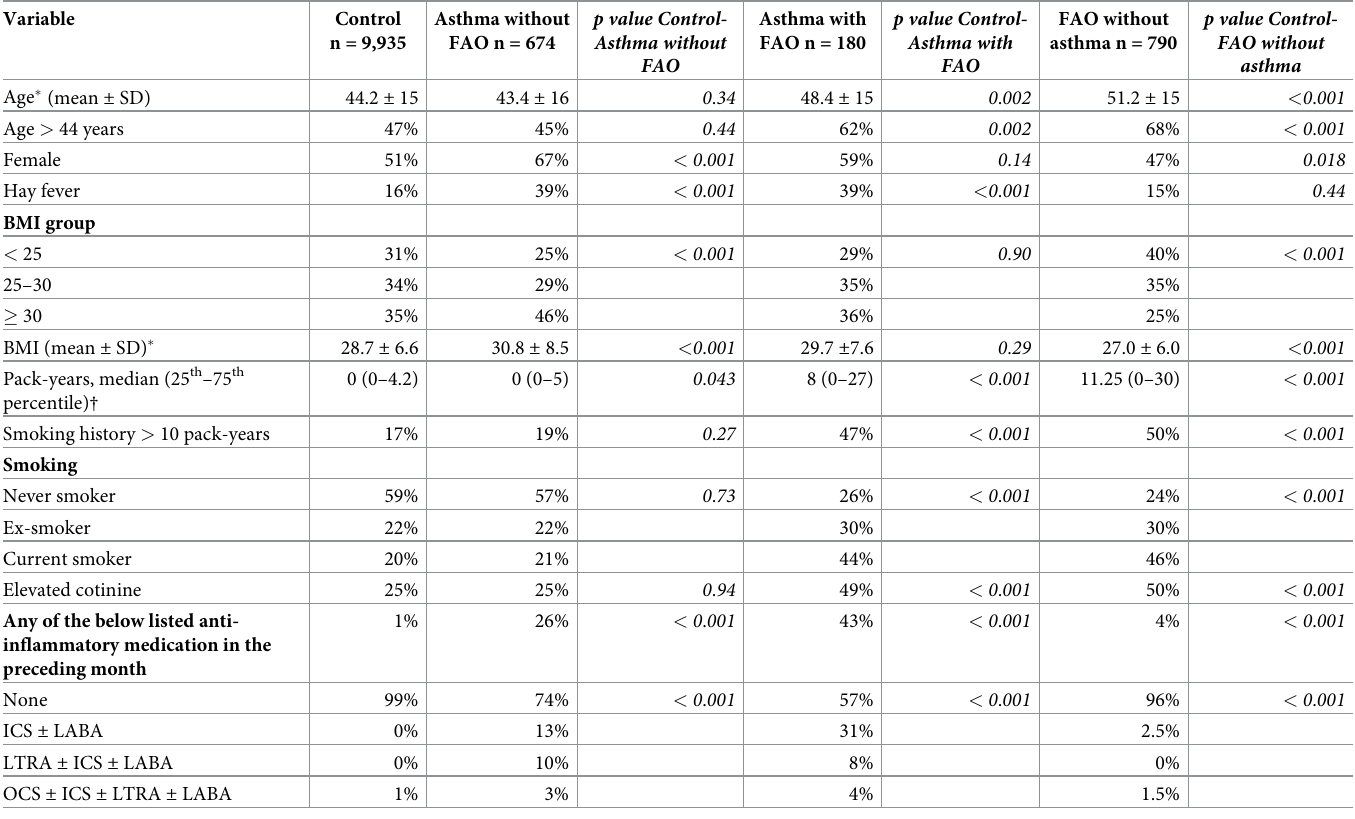
Table 1. Characteristics of the asthma and FAO groups compared with